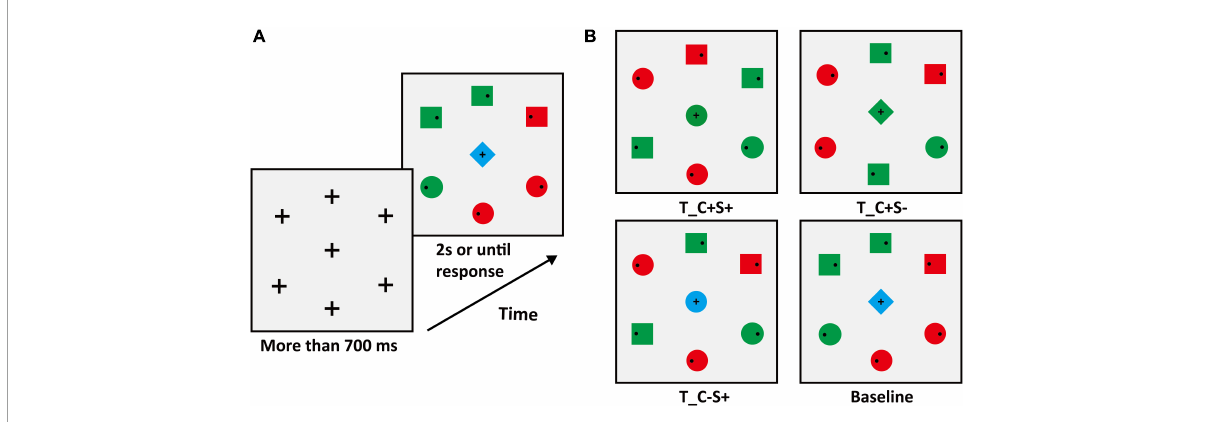
FIGURE3 (A) Schematic procedure of Experiment 1B (e.g., target: green circle). (B) The condition of the center stimuli. T_ = target, D_ = distractor; C = color, S = shape; the “ + ” stands for same, “–” stands for